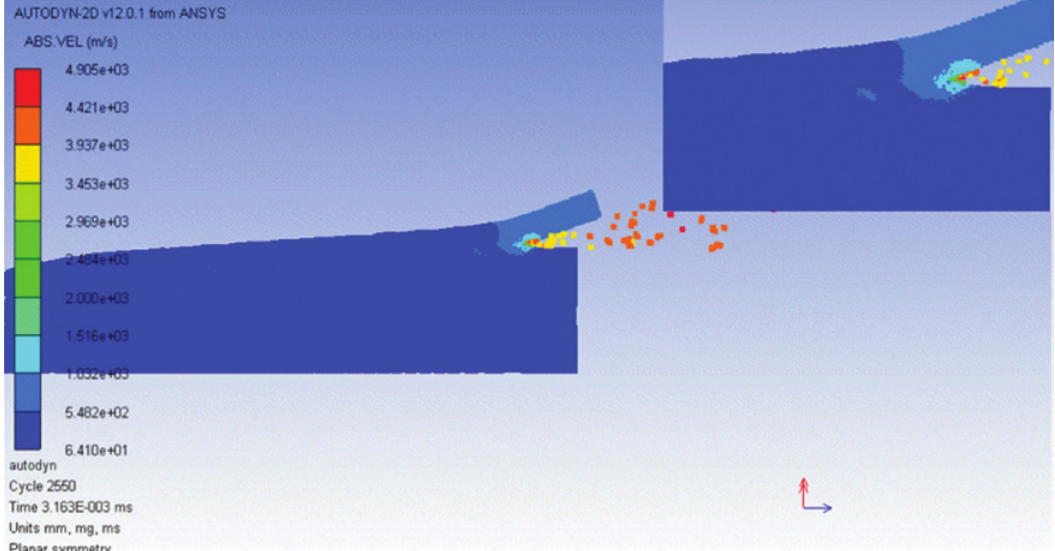
Figure 6: The velocity distribution of combination in the